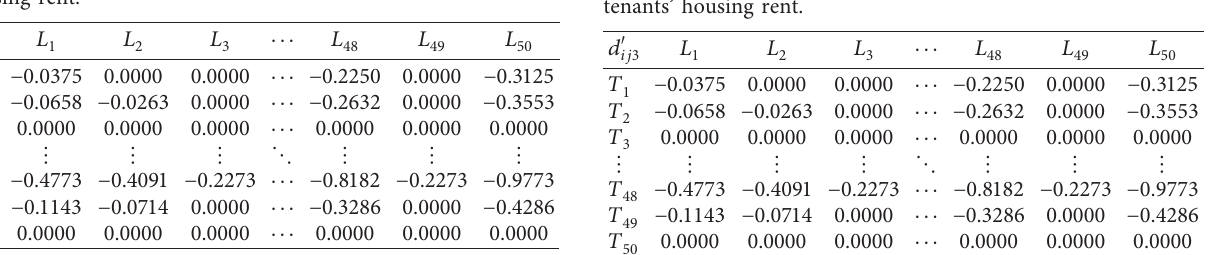
Table 26: Normative profit and loss matrix D